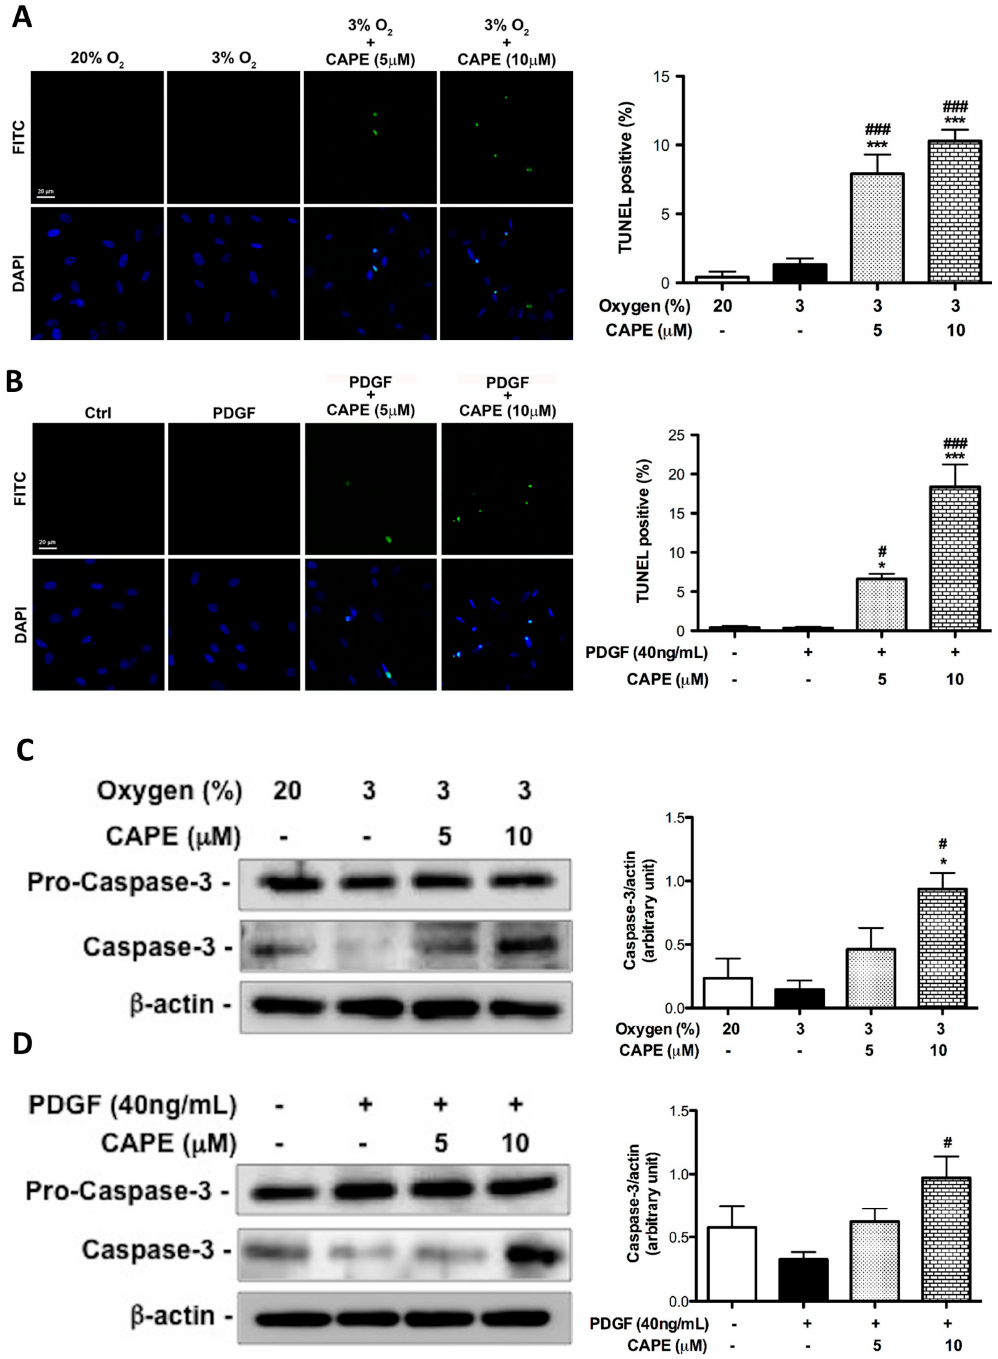
Figure 6. Up-regulation of caspase3 by CAPE promotes hypoxia- and PDGF-BB-induced resistance to apoptosis human PASMCs. ( A , B ) Cells were pretreated in the absence of inhibitor or with CAPE (5 or 10 μ M) for 2 h, and then were cultured for 24 h in normoxia (20%), hypoxia (3%), or PDGF-BB. Cell apoptosis as measured by TUNEL assay. Apoptosis rate was calculated as a percent of TUNEL-positive cells out of a total number of cells indicated by DAPI-positive staining for each microscopic field. ( C ) Cells were cultured for 6 h in normoxia (20%) or hypoxia (3%) with or without CAPE (5 or 10 µ M). ( D ) Cells were pretreated with CAPE for 2 h, and then treated with or without PDGF-BB for 6 h. Procaspase-3 and activated caspase-3 protein expression was evaluated by Western blot. Values are the mean ± SEM of three independent experiments. * p < 0.05; *** p < 0.01, as compared with the control group. # p < 0.05; ### p < 0.01, as compared with the cells exposed to hypoxia or